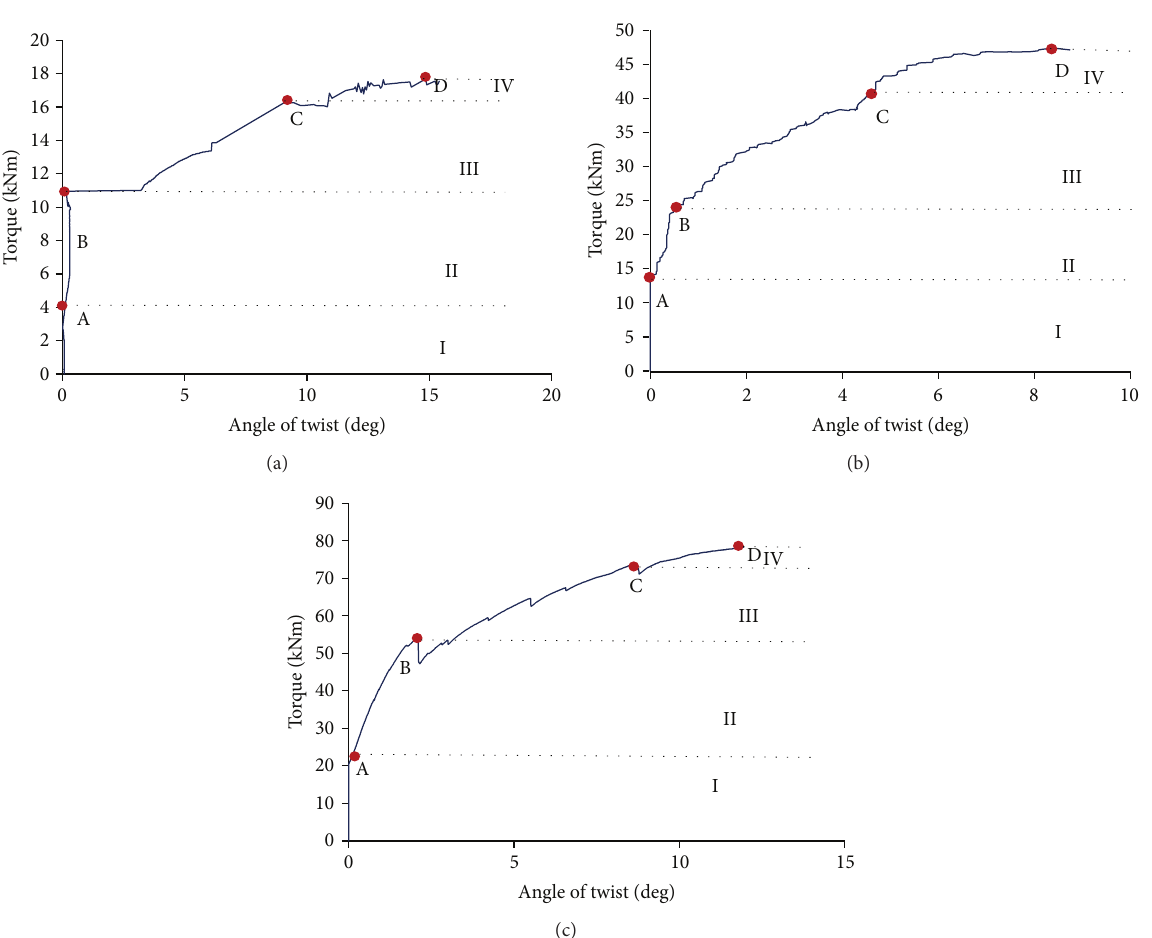
sensors and identified as an AE hit. During the initial stage of loading, the cumulative AE hit was low until occurrence